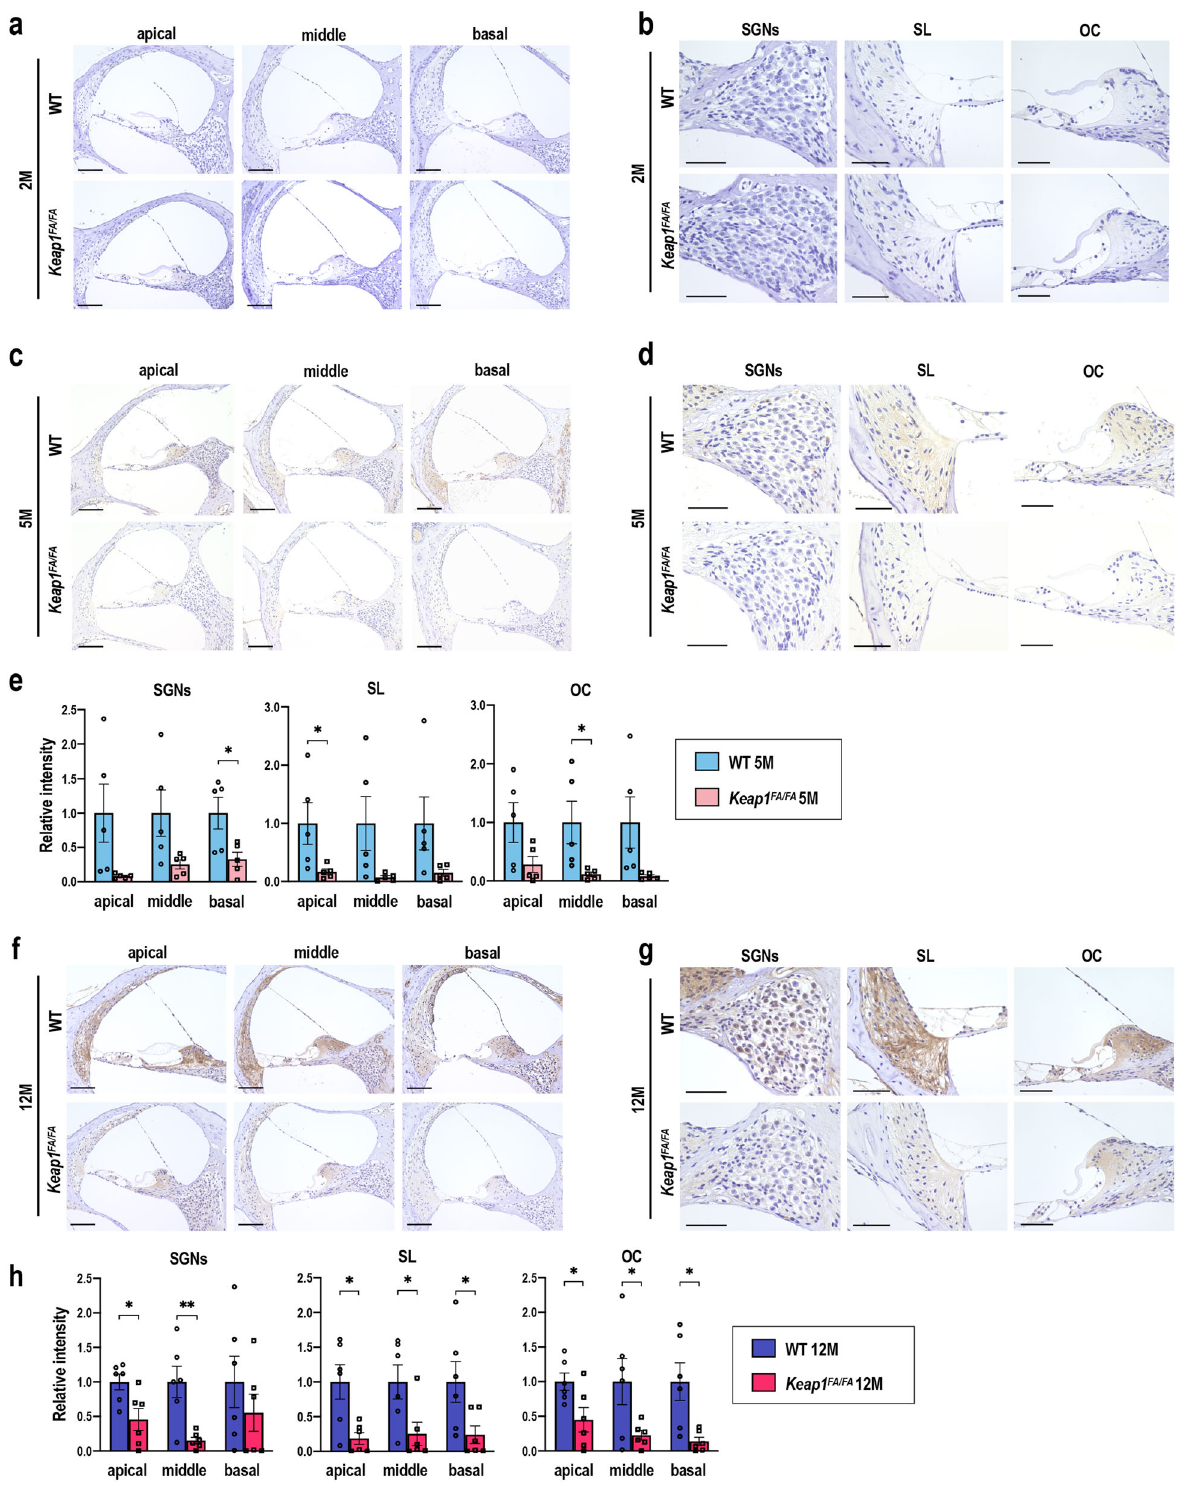
Fig. 11 Accumulation of 4-HNE in the WT and Keap1 FA/FA cochleae during aging. Immunohistochemical staining with 4-HNE in the cochleae at each turn of the Keap1 FA/FA and WT mice at 2 ( a ), 5 ( c ), and 12 months ( f ). High-power fi eld images are shown for each region (SGNs, SL, and organ of Corti (OC)) in the cochleae at the middle turns in the Keap1 FA/FA and WT mice at 2 ( b ), 5 ( d ), and 12 months ( g ) of age. The experiments were performed for fi ve samples each of 2- and 5-month-old mice and six samples of 12-month-old mice. Relative intensities of the staining at each turn of 5-month-old cochlea ( e ) and 12-month-old cochlea ( h ) were semi-quanti fi ed. Average staining intensities of WT mice are set as 1. The data represent the mean ± SEM. * P < 0.05, ** P < 0.01. Unpaired two-tailed Student ’ s t -test was applied. Scale bars correspond to 100 μ m ( a , c , f ) and 50 μ m ( b , d , g